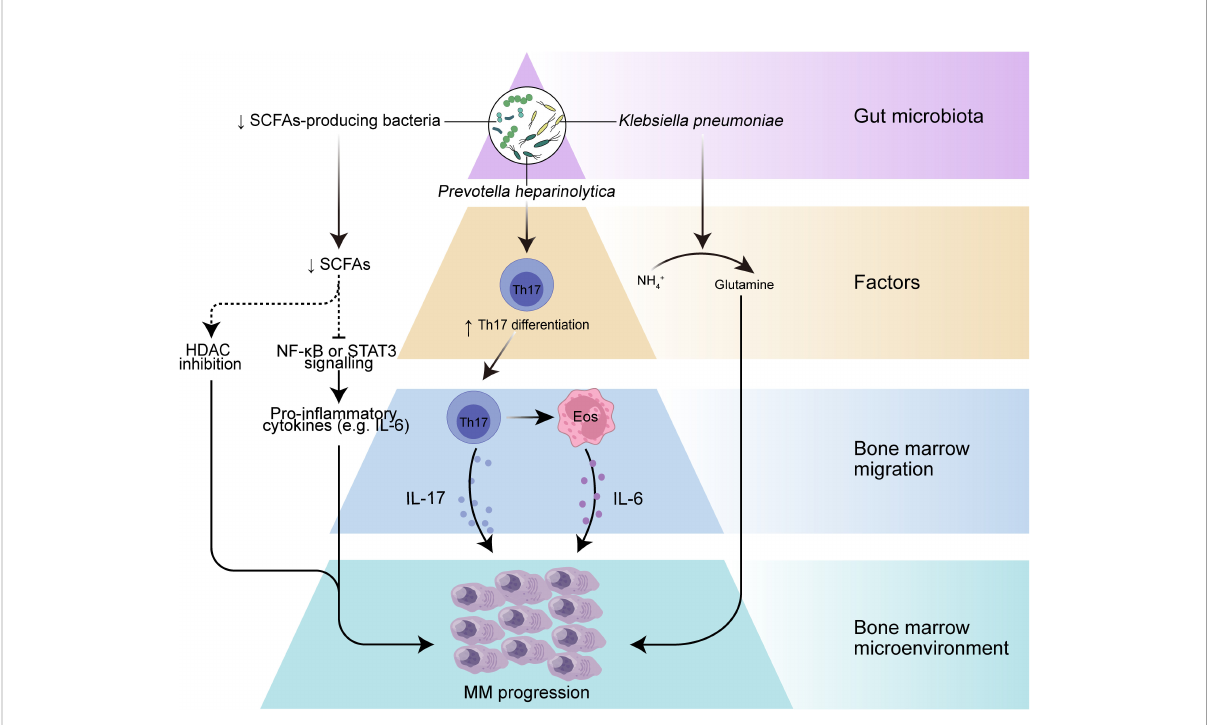
FIGURE 1 The role of gut microbiota in myeloma progression. Dysbiosis of the gut microbiota leads to a reduction in the microbiota-producing SCFAs, which can result in decreased levels of SCFAs, leading to increased activation of in fl ammatory mediators such as IL-6 and NF- k B pathways, and may further drive myeloma progression. A selective increase in nitrogen-recycling microbiota in the intestinal lumen may promote glutamine synthesis and lead to myeloma progression. In addition, speci fi c bacteria such as Prevotella heparinolytica promote intestinal epithelial colonization and bone marrow (BM) migration of Th 17 cells in the Vk*MYC mouse model, which can lead to the production of IL-17 by Th 17 cells in the BM and further activate eosinophils and promote IL-6 release, thereby contributing to in fl ammation-mediated tumor